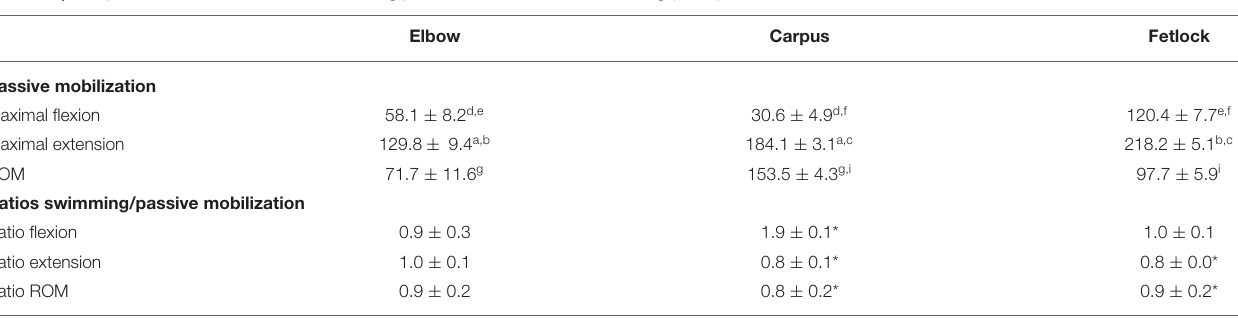
TABLE 3 | Comparison between ROM obtained during passive mobilization and swimming (n =